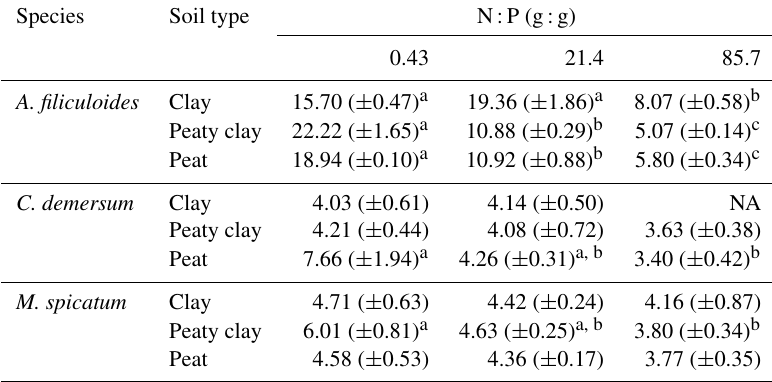
Table 2. Plant tissue ratios between N and P for different macrophytes subjected to different nutrient loadings (0.43, 21.4 and